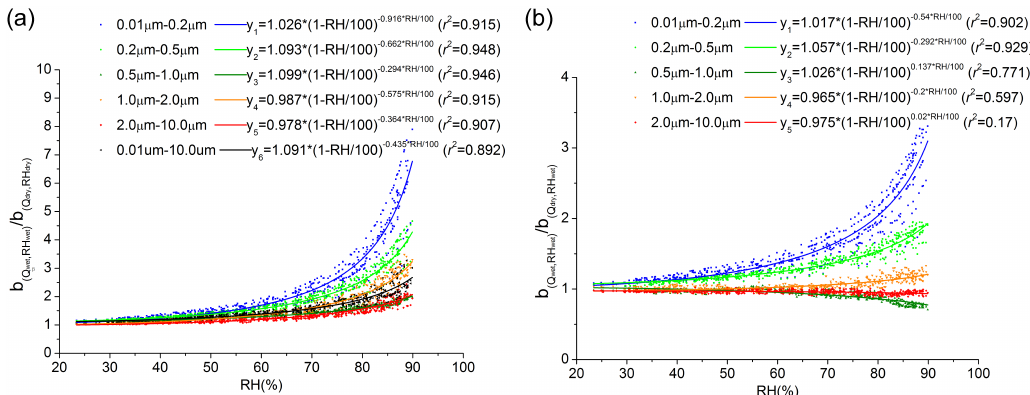
Figure 10. Growth multiples of the extinction coefficient (a) and the change in the efficiency factor (b) in different size segments at ambient relative